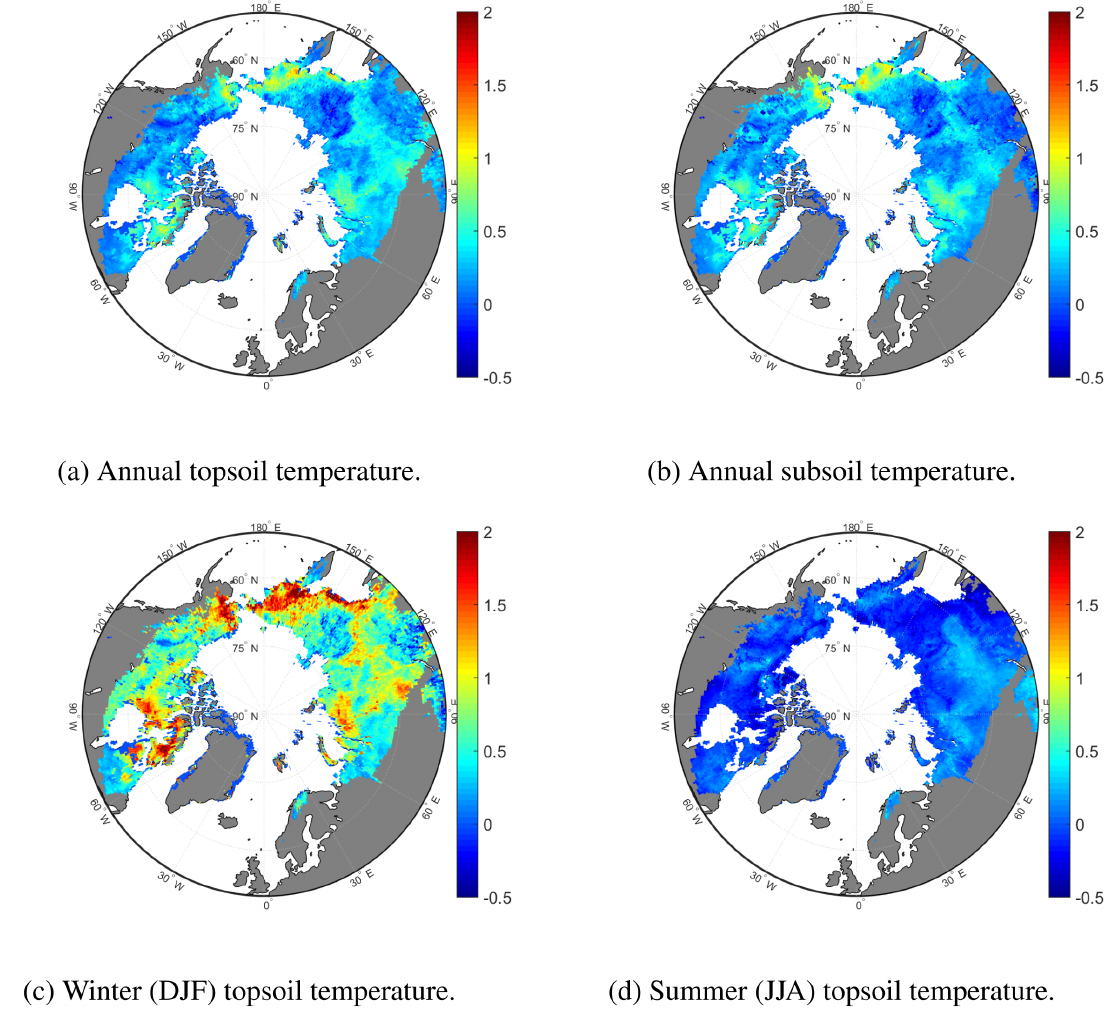
Figure 9. Comparison of 1980–2009 average soil temperature (REDVAR minus CNTL). Shown are absolute differences ( ◦ C). Topsoil and subsoil refer to depths of 3cm and 38m,